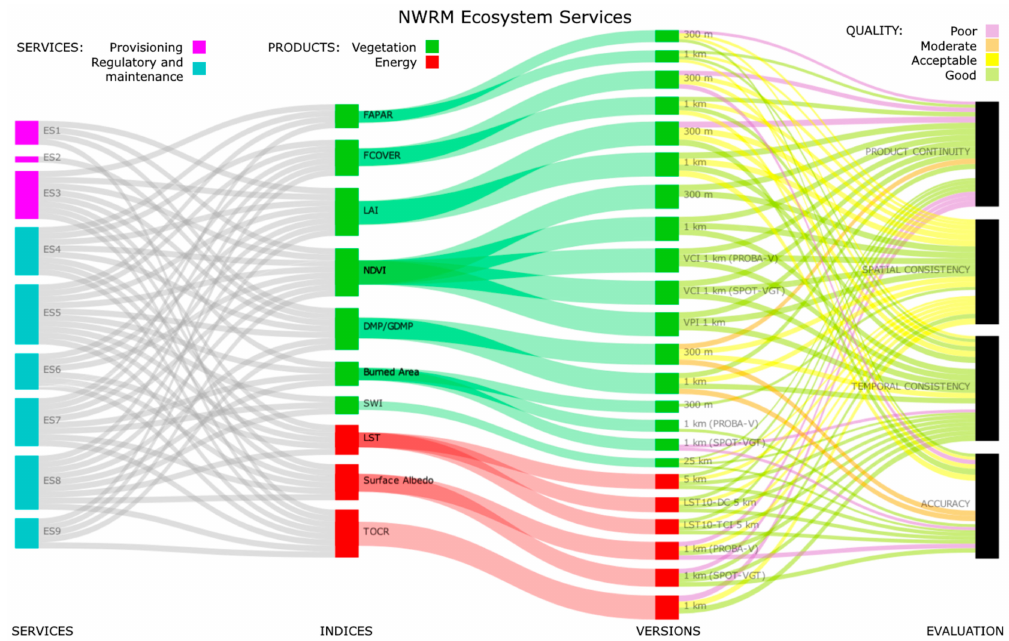
Figure A5. Sankey diagram linking the vegetation and energy indices that according to previous experiences are suitable for monitoring the ecosystem services (ES) delivered by natural water retention measures (NWRMs).